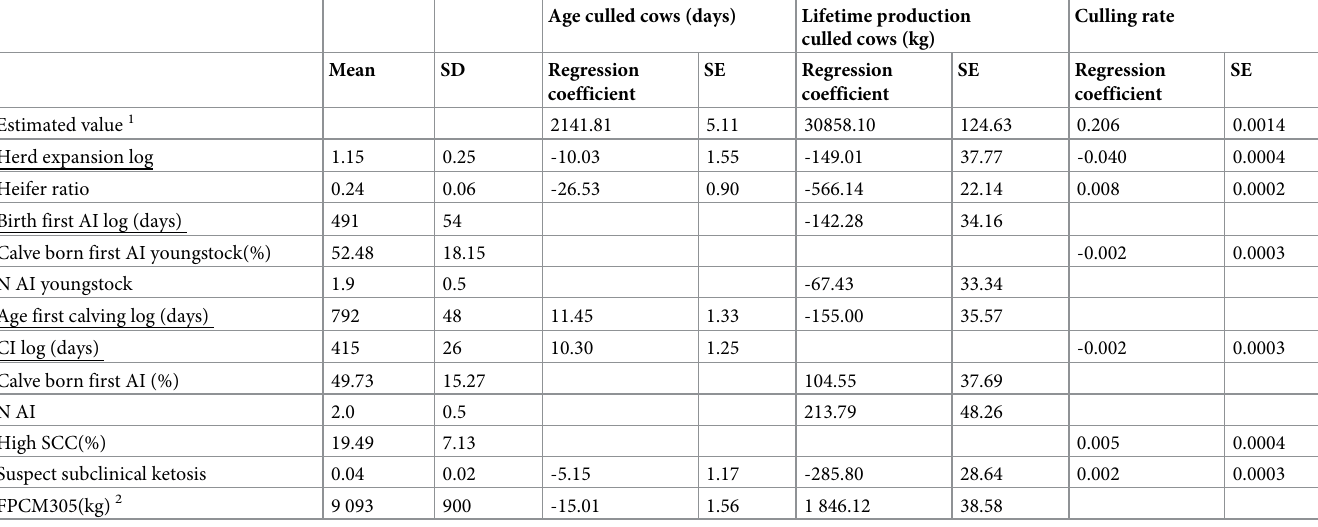
Table 4. The estimated association of continuous herd performance indicators on age and lifetime milk production of culled milking cows and culling rate. The coefficients of the continuous variables indicate the change in longevity variables resulting from a SD increase in mean